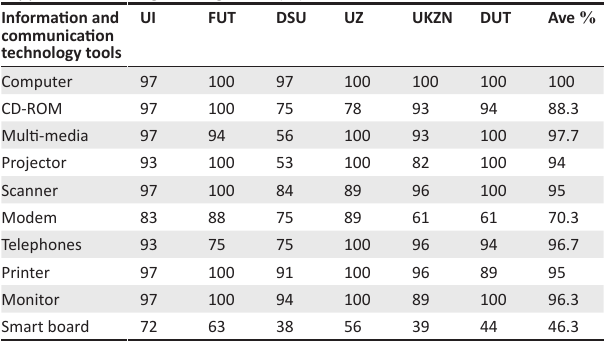
TABLE 2: Availability of information and communication technology tools for the support of knowledge management ( %